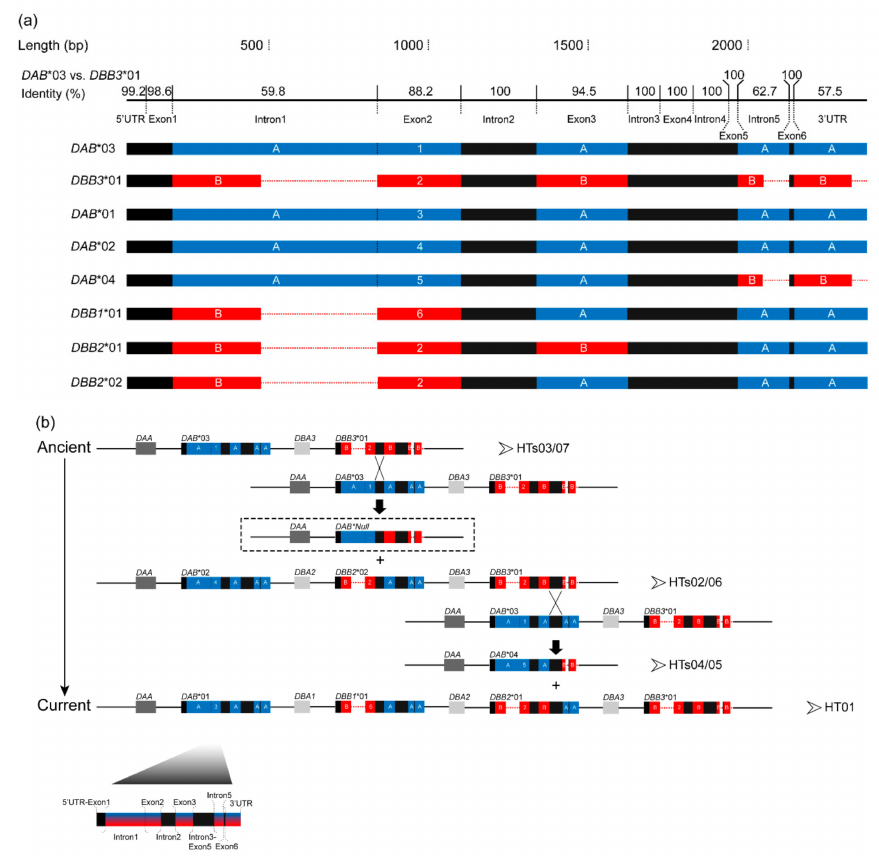
Figure 4. Comparison of the full-length II β sequences ( a ) and evolutionary model of the class II regions in seven MHC haplotypes ( b ) in crested ibis. Blue (A) and red (B) boxes respectively indicate “type A” and “type B” regions represented by DAB *03 and DBB3 *01. Numbers on exon 2 represent di ff erent nucleotide sequences. Black boxes indicate highly similar homologous regions which provide good opportunities for unequal crossing over between two ancestral II β genes. Dotted lines indicate alignment gaps. ( a ) Sequence identity (%) for each gene region was calculated in Lasergene software (DNASTAR Inc., Madison, WI) for DAB *03 vs. DBB3 *01. ( b ) Dark and light grey boxes represent DAA and DBA s, respectively. The scale for intragenic regions is shown in the lower left corner. Breakpoints of recombination (as indicated by RDP) are shown by black crosses (intron 2 and intron 3–exon 5). The haplotype framed by the dashed-line was not detected in this